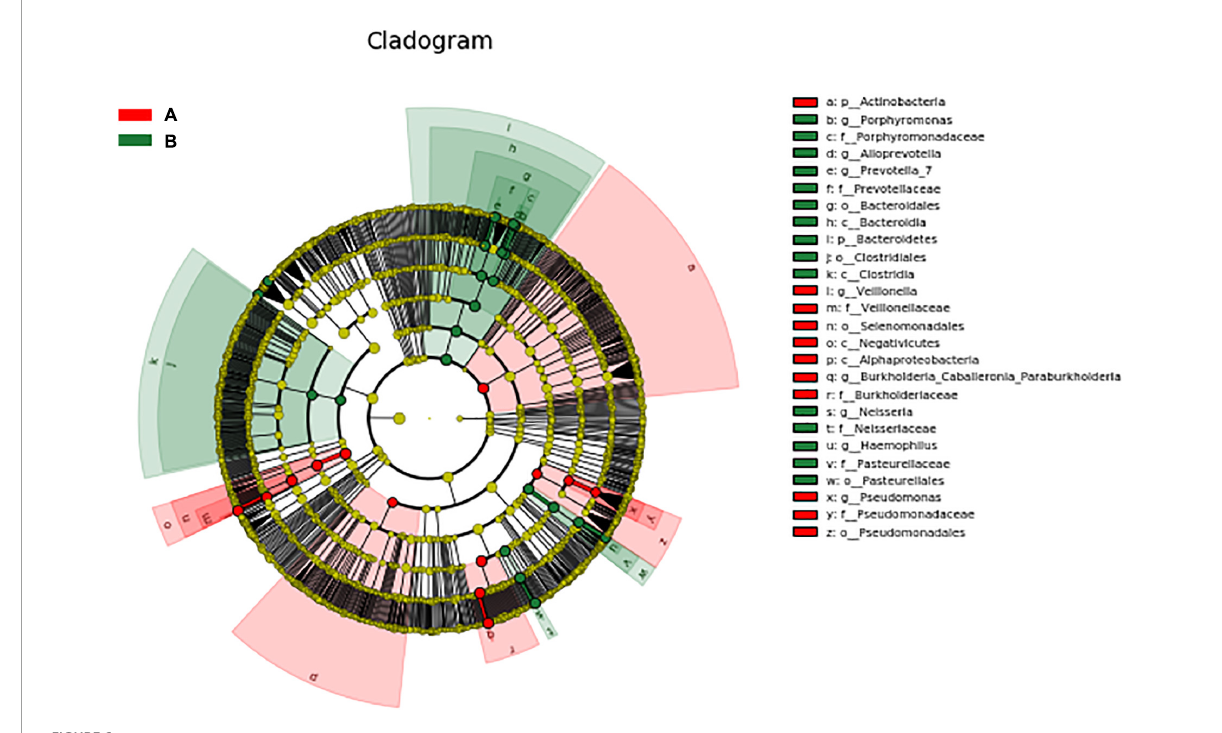
FIGURE6 Evolutionary clade of significantly different species.